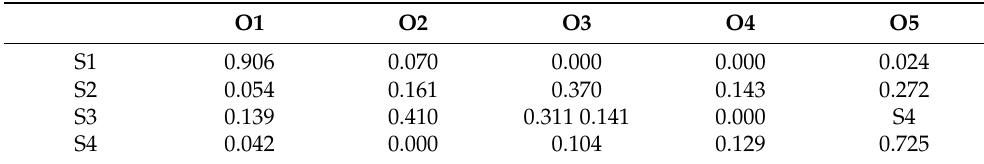
Table 2. Probability values of transitions from the observed states.